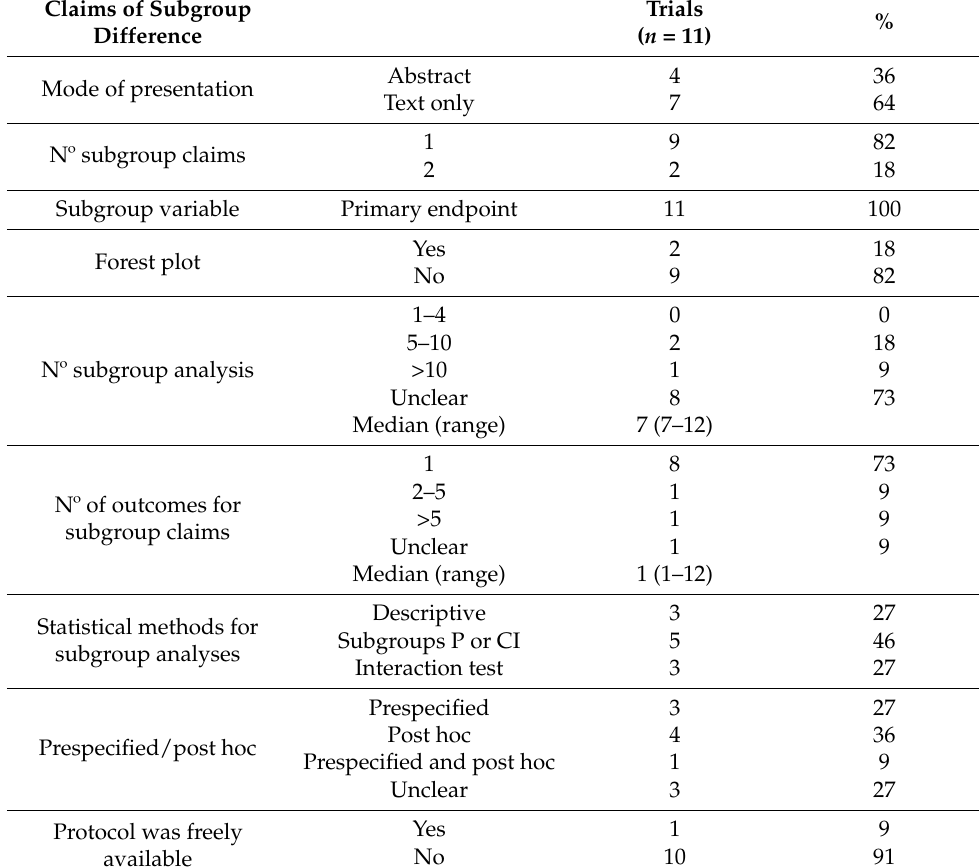
Table 3. Characteristics of trials with claims of subgroup differences.